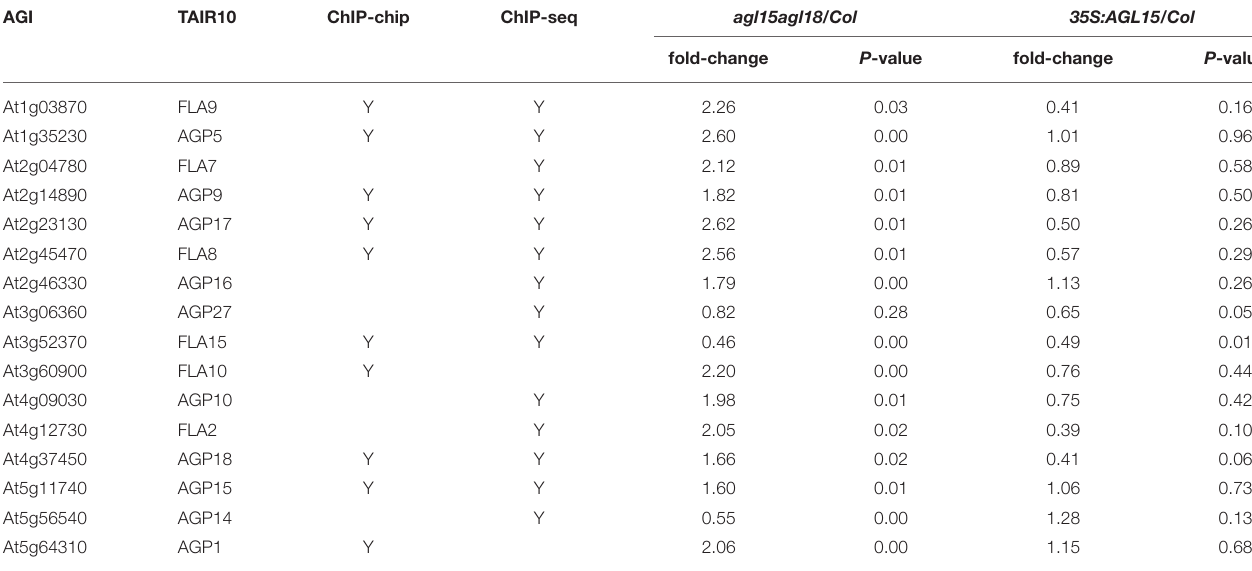
TABLE 2 | AGP and FLA genes that show transcript response to AGL15 and are direct targets as determined by ChIP-chip or ChIP-seq. AGI TAIR10 ChIP-chip